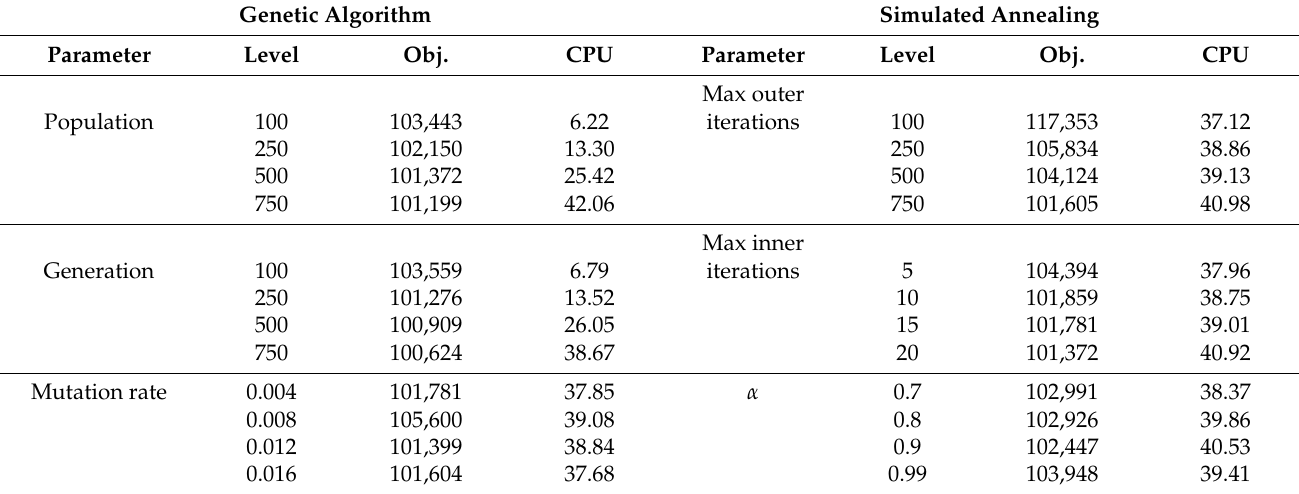
Table A3. Tested parameter values for GA and SA.